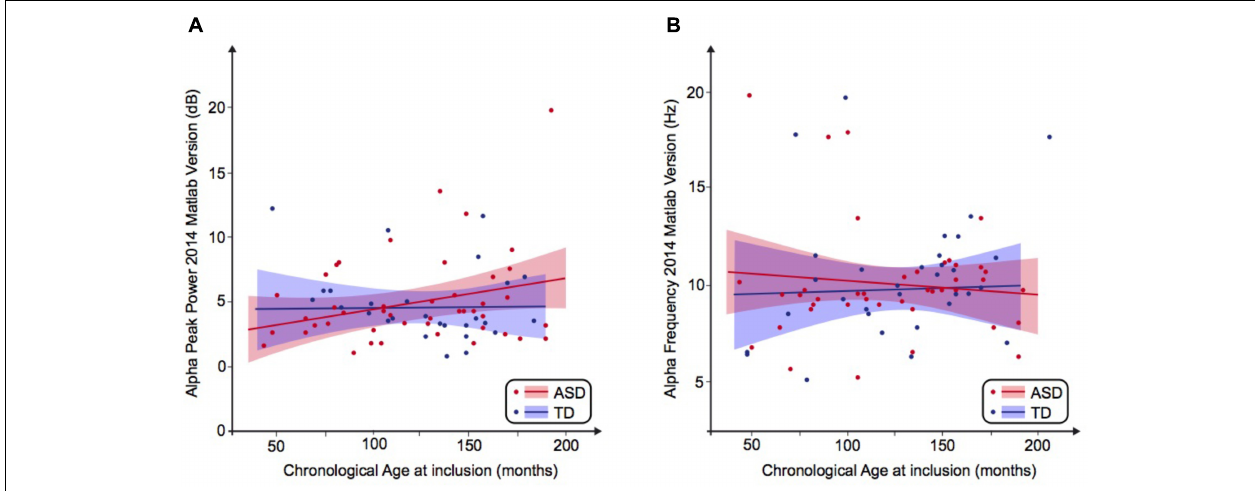
FIGURE 2 | Alpha waves normative modeling in patients and TD participants: effect of age heterogeneity on alpha peak power. (A) Shows the raw data with the non-parametric normative model overlaid in blue. (B) Summarises the normative scores with an histogram. ASD, autism spectrum disorder; TD, typically developing participants.